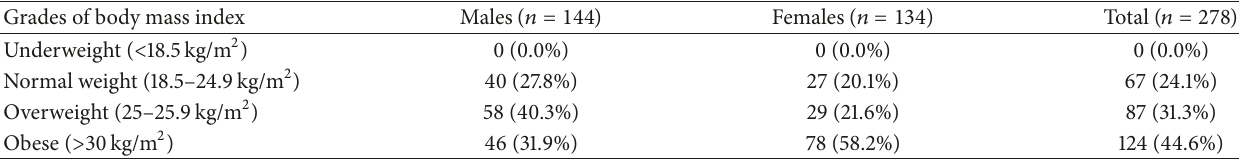
Table 2: Grades of body mass index according to participants’ gender. Grades of body mass